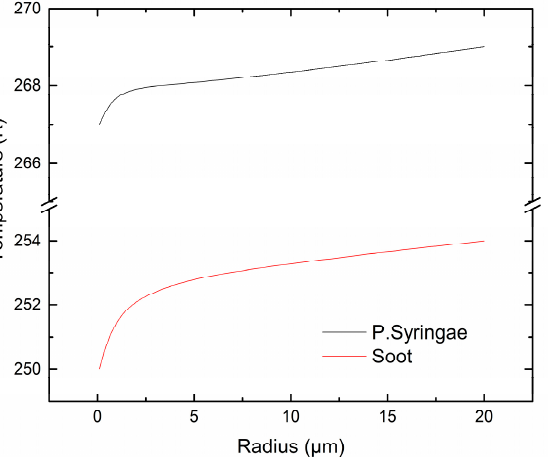
Figure 2. Relationship between ambient temperature (K) and radius of pre-existing particles ( μ m) at IN activation